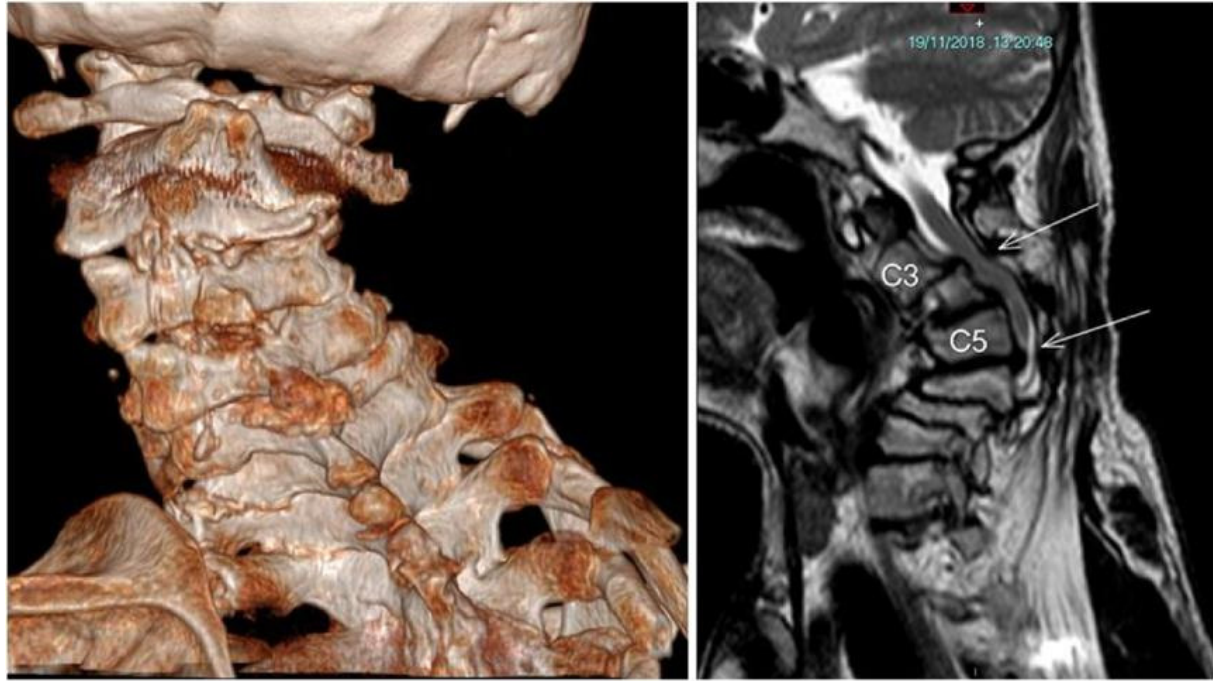
Figure 1. Medical imaging of pre-operative cervical spine: sagittal view from 3D virtual rendering from CT DICOM viewer ( left ) and MRI scan ( right ). In the latter, the third (C3) and fifth (C5) cervical vertebrae are indicated by arrows.